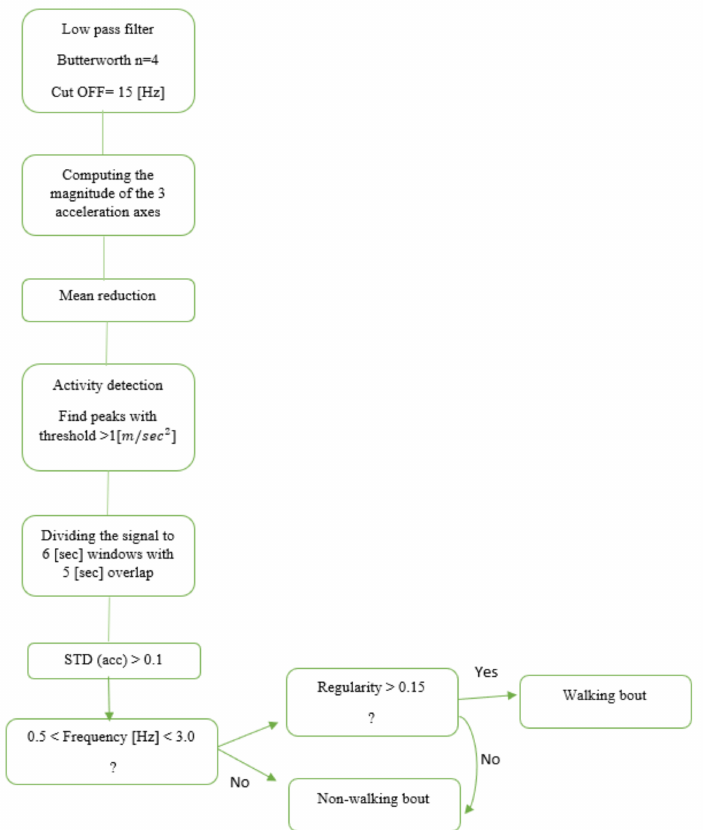
Figure 1. Flowchart based on Keren’s gait detection algorithm [24]. The raw data were divided into six-second windows. The Euclidean norm of the 3-axis accelerometer signal was calculated to minimize any effects of the sensor’s placement and angle or orientation dependency. An activity threshold was set to 1 (m/s 2 ) to remove areas in the recording with low activity. Then, each window was classified as a walking bout based on the time and frequency domain